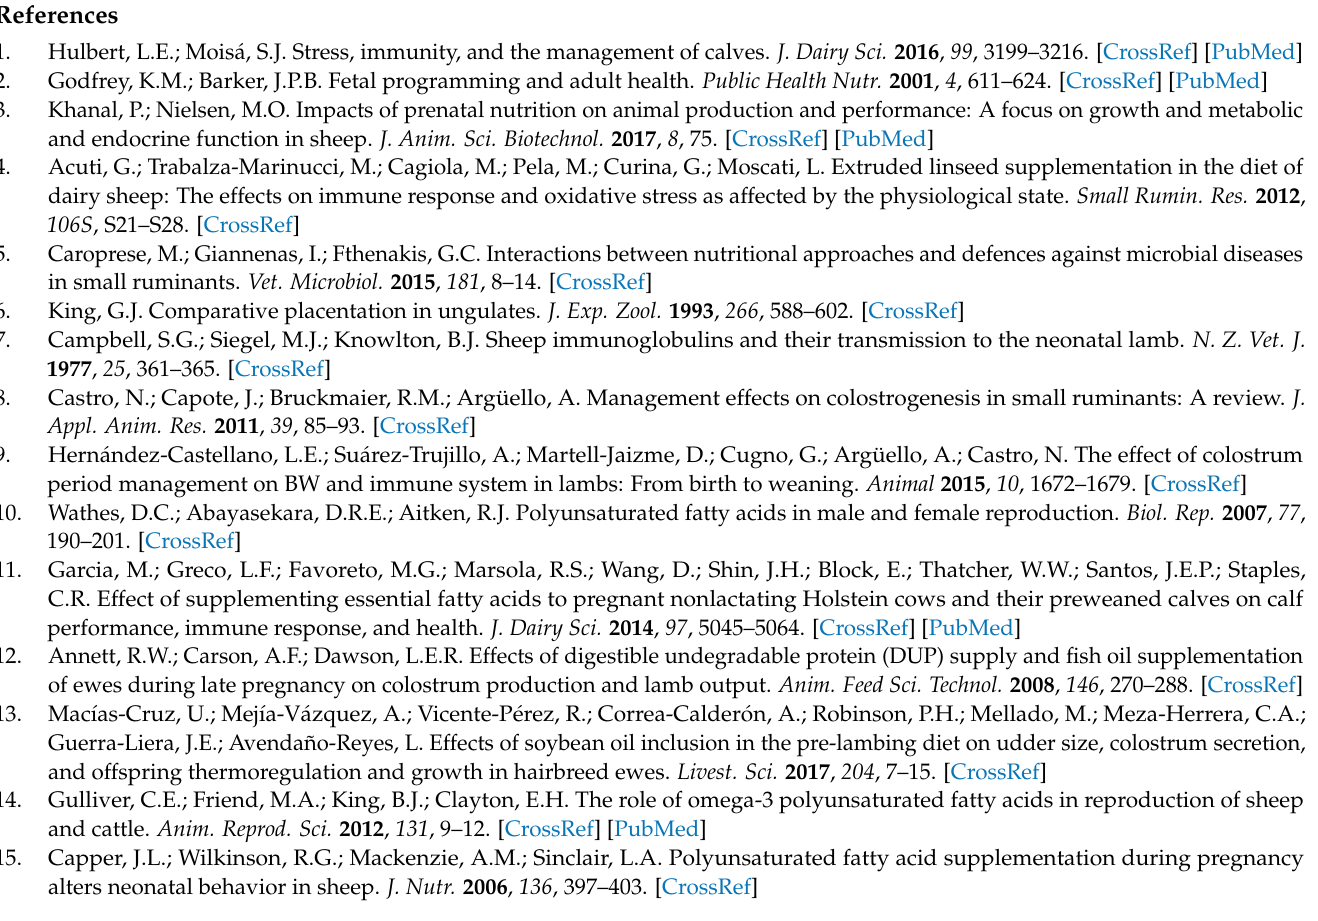
fatty acid composition. Figure S1: Differences between plasma cortisol concentration of lambs